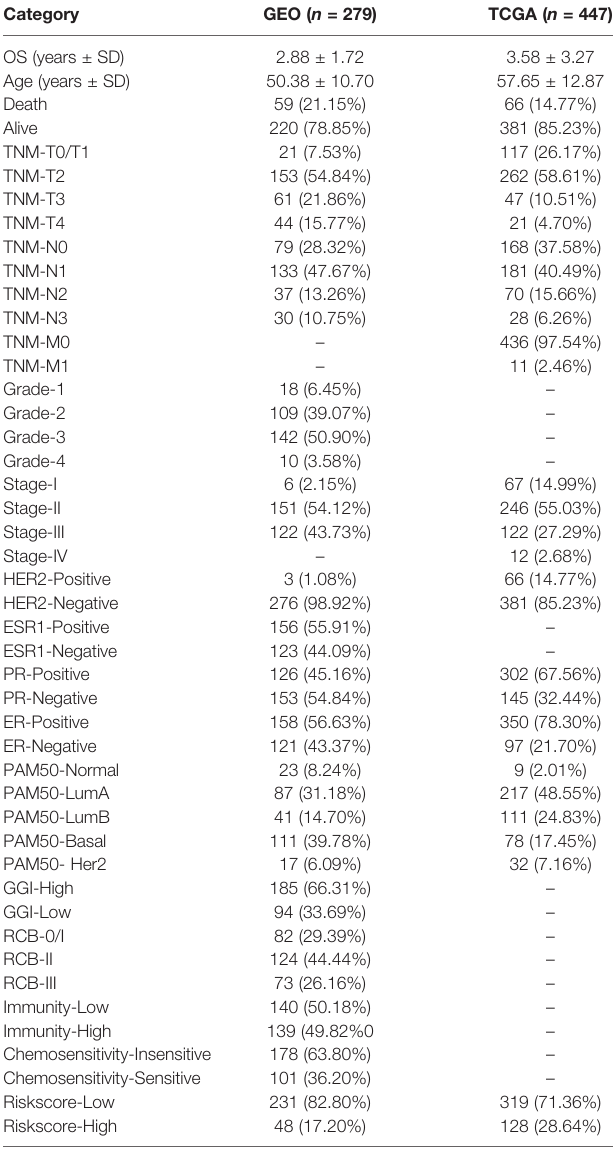
TABLE 2 | Detailed clinical information of the patients included in the training and validation datasets.